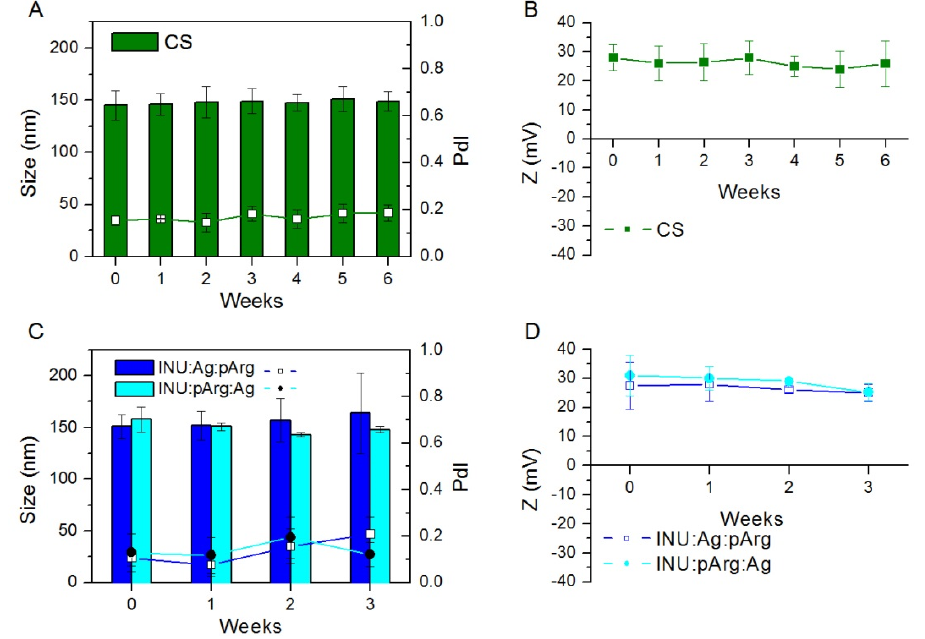
Figure 2. Size (bars), PdI, and Zeta-potential (lines and symbols) of Imiquimod-loaded CS ( A and B ), INU:Ag:pArg and INU:pArg:Ag ( C and D ) nanocapsules stored at 4 °C at different time points. Due